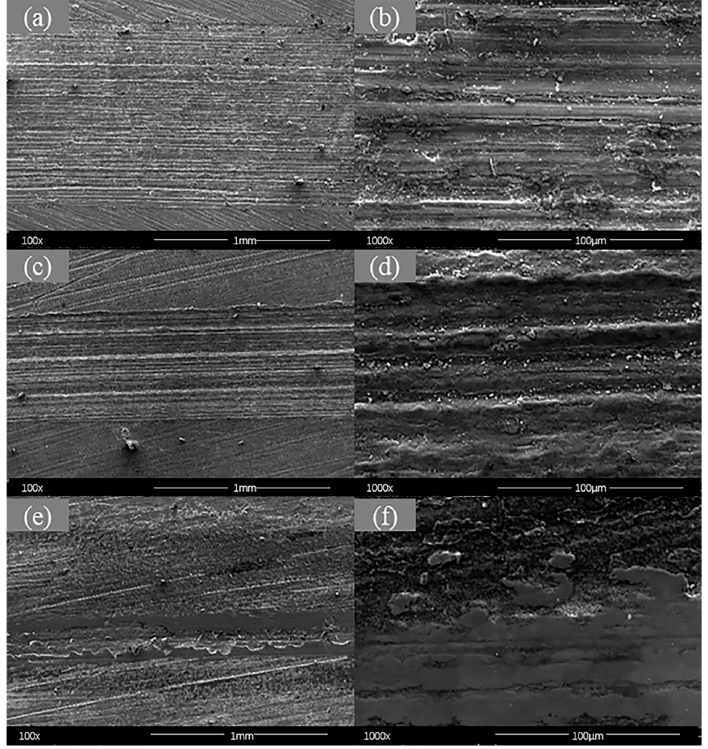
Figure 13. Wear morphology of Ti-6Al-4V alloy at different temperature. ( a , b ): 25 °C; ( c , d ): 350 °C; ( e , f ): 700 °C. According to the wear cross-section trajectory curve of Ti-6Al-4V alloy at different temperatures, the wear depth and width are decreased with the increase of temperature. As the temperature increases, the surface material softens and the friction resistance de- creases. At the same time, the peeled oxide layer is stuck on the grinding surface during the friction and wear reciprocation process, and enters the groove or furrow of the wear scar and adheres to the surface of the titanium alloy, acting as a lubricant to reduce the wear of Ti-6Al-4V. Figure 14 shows the wear-cross section trajectory curve of Ti-6Al-4V alloy at different temperatures. The width and depth of wear marks at room temperature are the maximum values at three different temperatures. Figure 15 ( a), (b) shows that there is a significant fur- row and a small amount of debris on the wear surface of the alloyed coating at room tem- perature. When the temperature rises to 350 °C, as shown in Figure 15c,d, there is a signifi- cant adhesion mark on the wear surface, and the amount of debris increases. As the temper- ature rises to 700 °C, the wear width is narrowed, and it is difficult to observe furrow and the adhesion traces of metal. However, serious brittle flaking are found on the wear surface, as shown in Figure 15e,f.